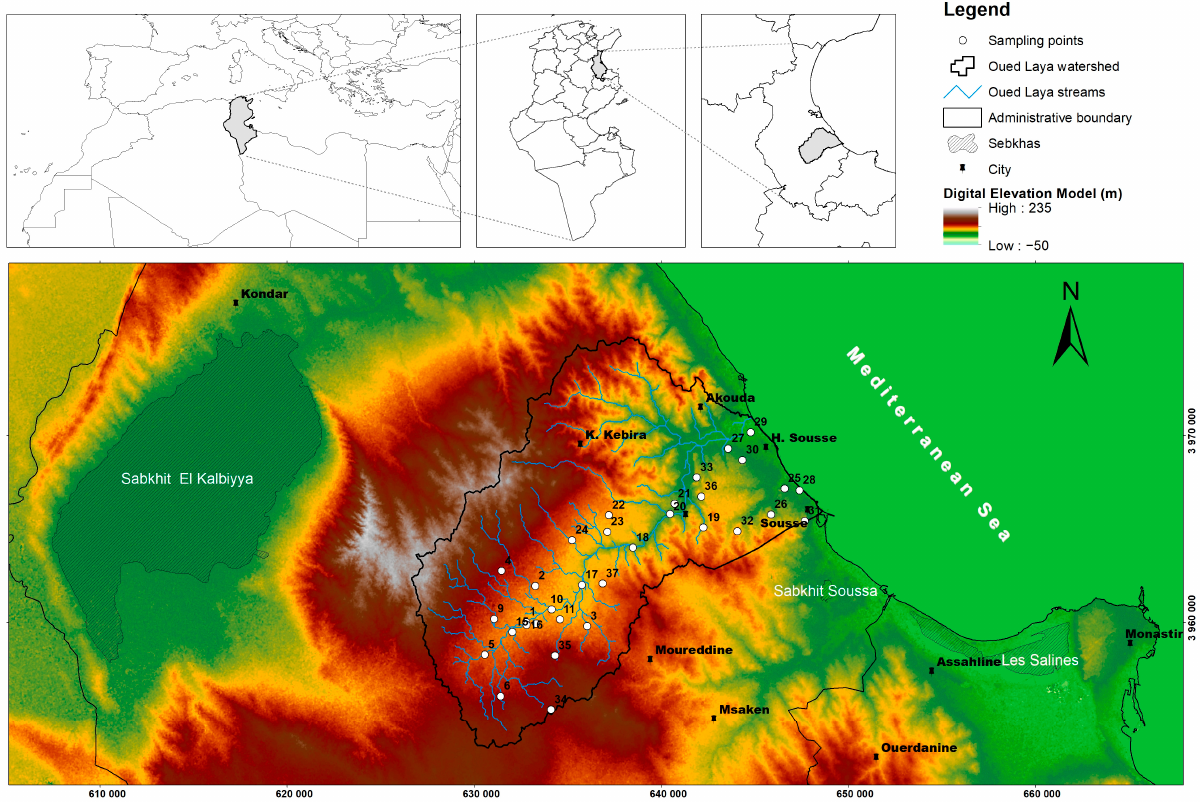
Figure 1. Location of the study area in Tunisia, in the governorate of Sousse and the sampled points.